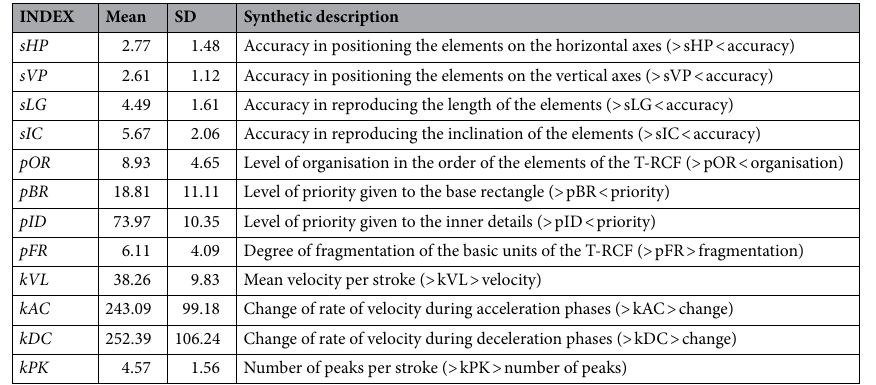
Table 2. Descriptive statistics (mean and standard deviation) and synthetic description of T-RCF indices. N = 97(excluding outliers); sHP horizontal placement accuracy, sVP vertical placement accuracy, sLG length accuracy, sIC inclination accuracy, pBR base rectangle priority, pID inner details priority, pOR organisation by relevance, pFR fragmentation, kVL mean velocity, kAC mean acceleration, kDC mean deceleration, kPK number of peak